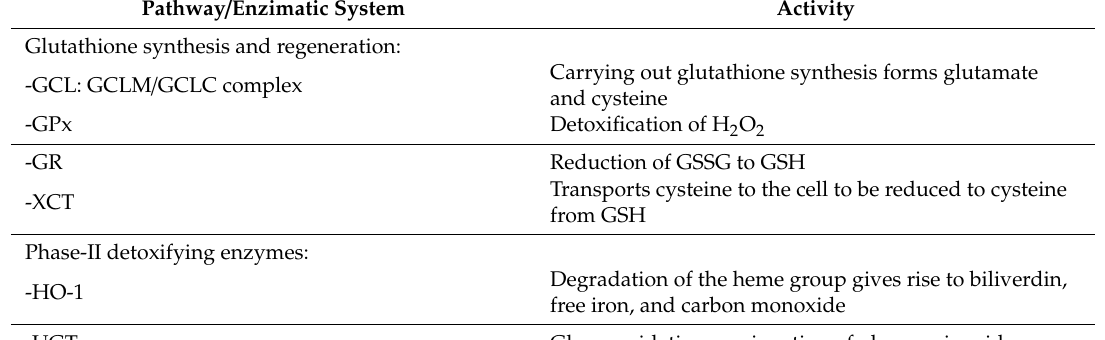
Table 1. Antioxidant cytoprotector system directed by Nrf2 [25–31]. Pathway / Enzimatic System